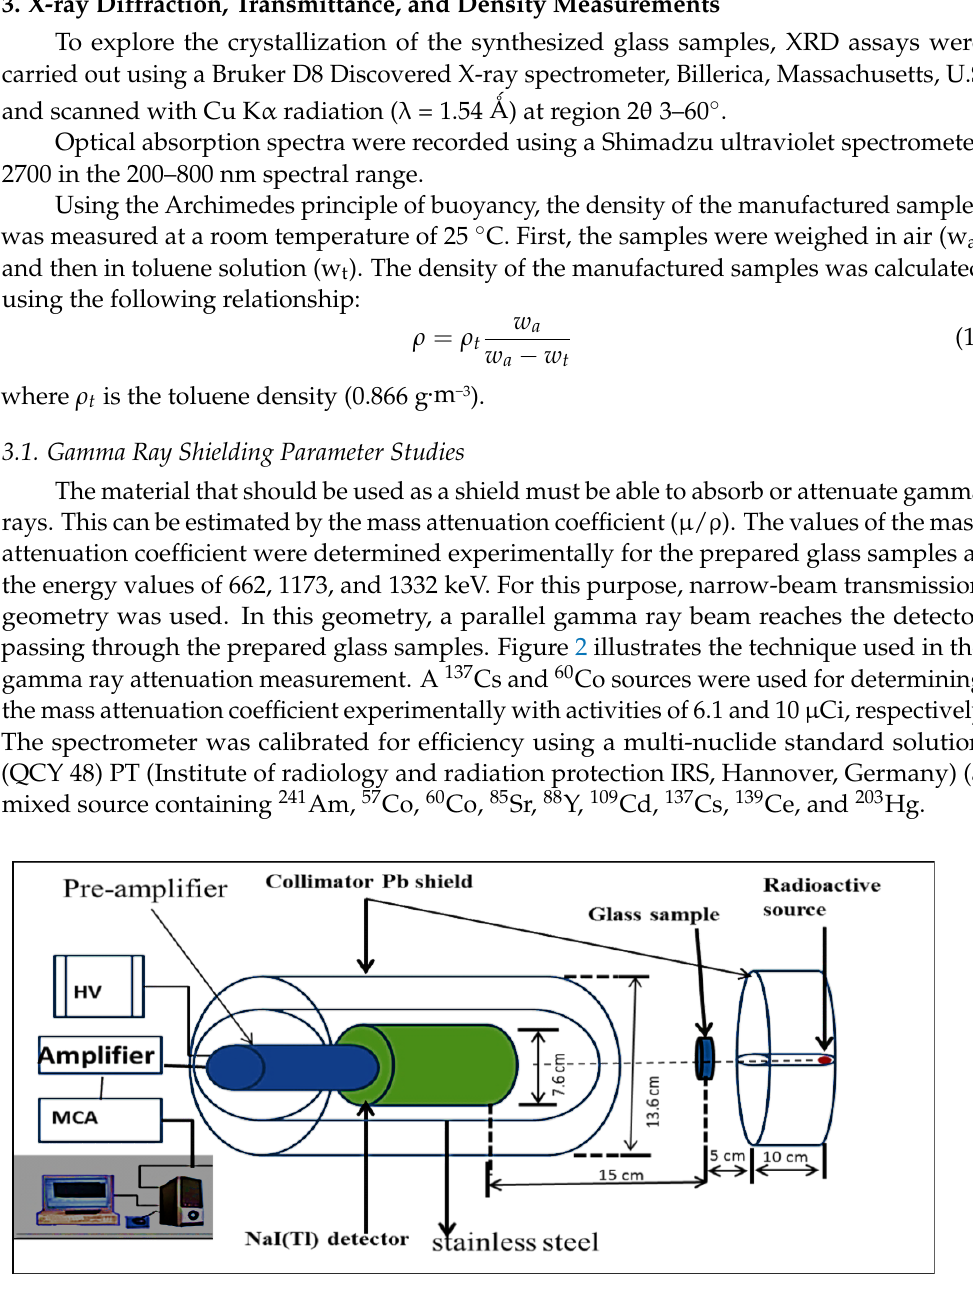
Figure 1. Glass system image.